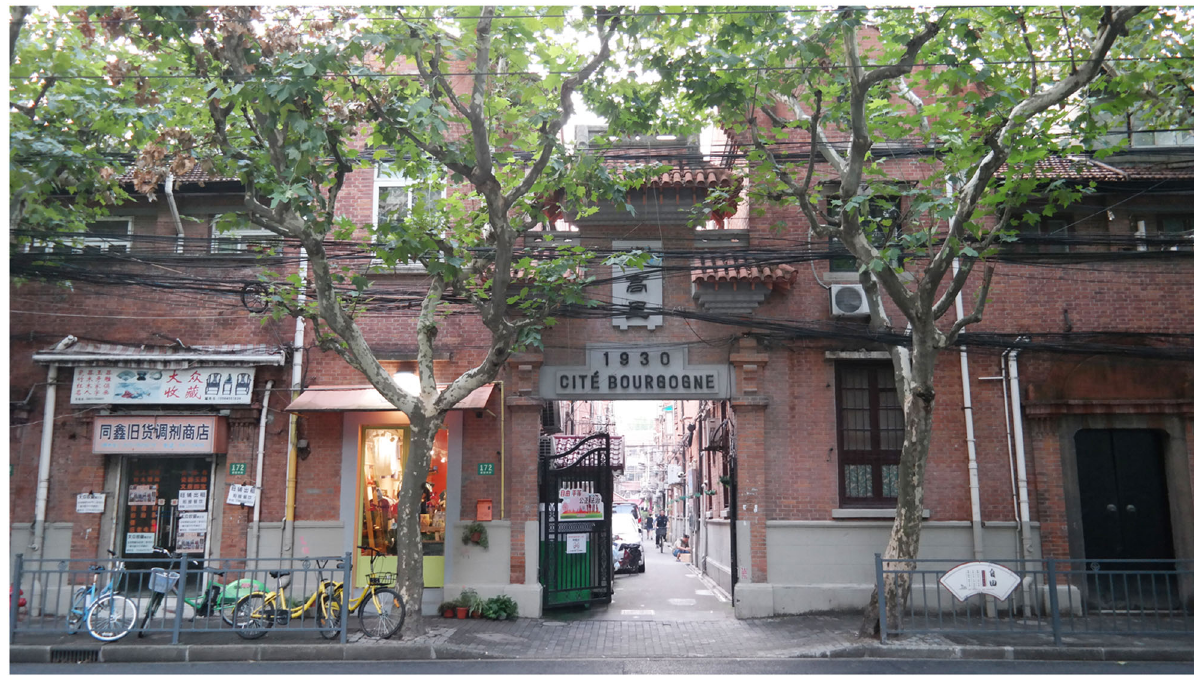
Fig. 4 The Chinese-looking archway of the Bugaoli neighbourhood, being an entrance gate of this community (Source: Kaiyi Zhu,